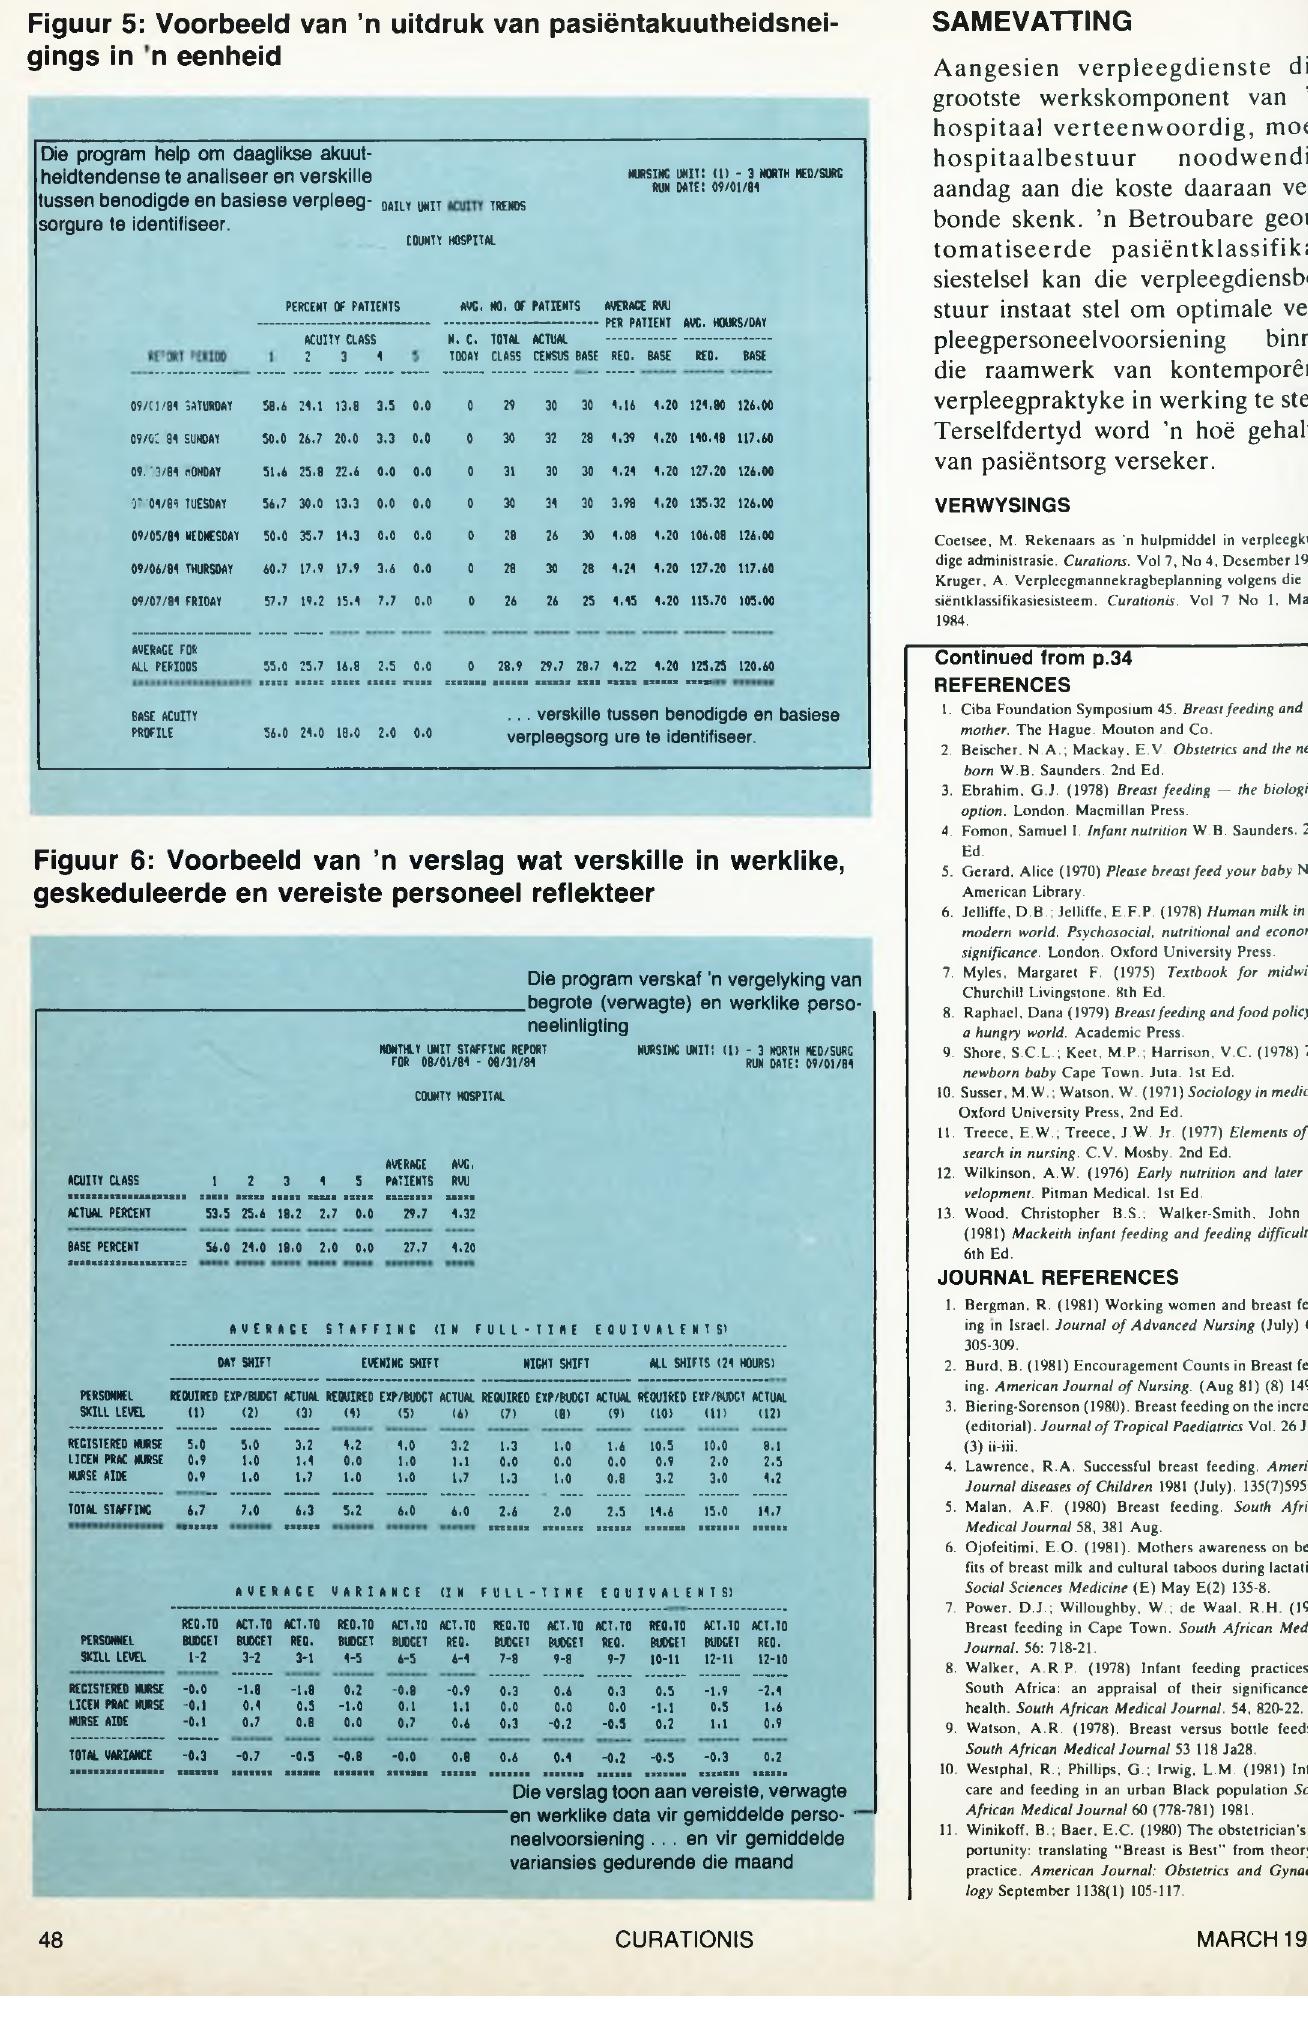
Die program help om daaglikse akuut- heidtendense te analiseer en verskille tussen benodigde en basiese verpleeg- 0AILY ^ it